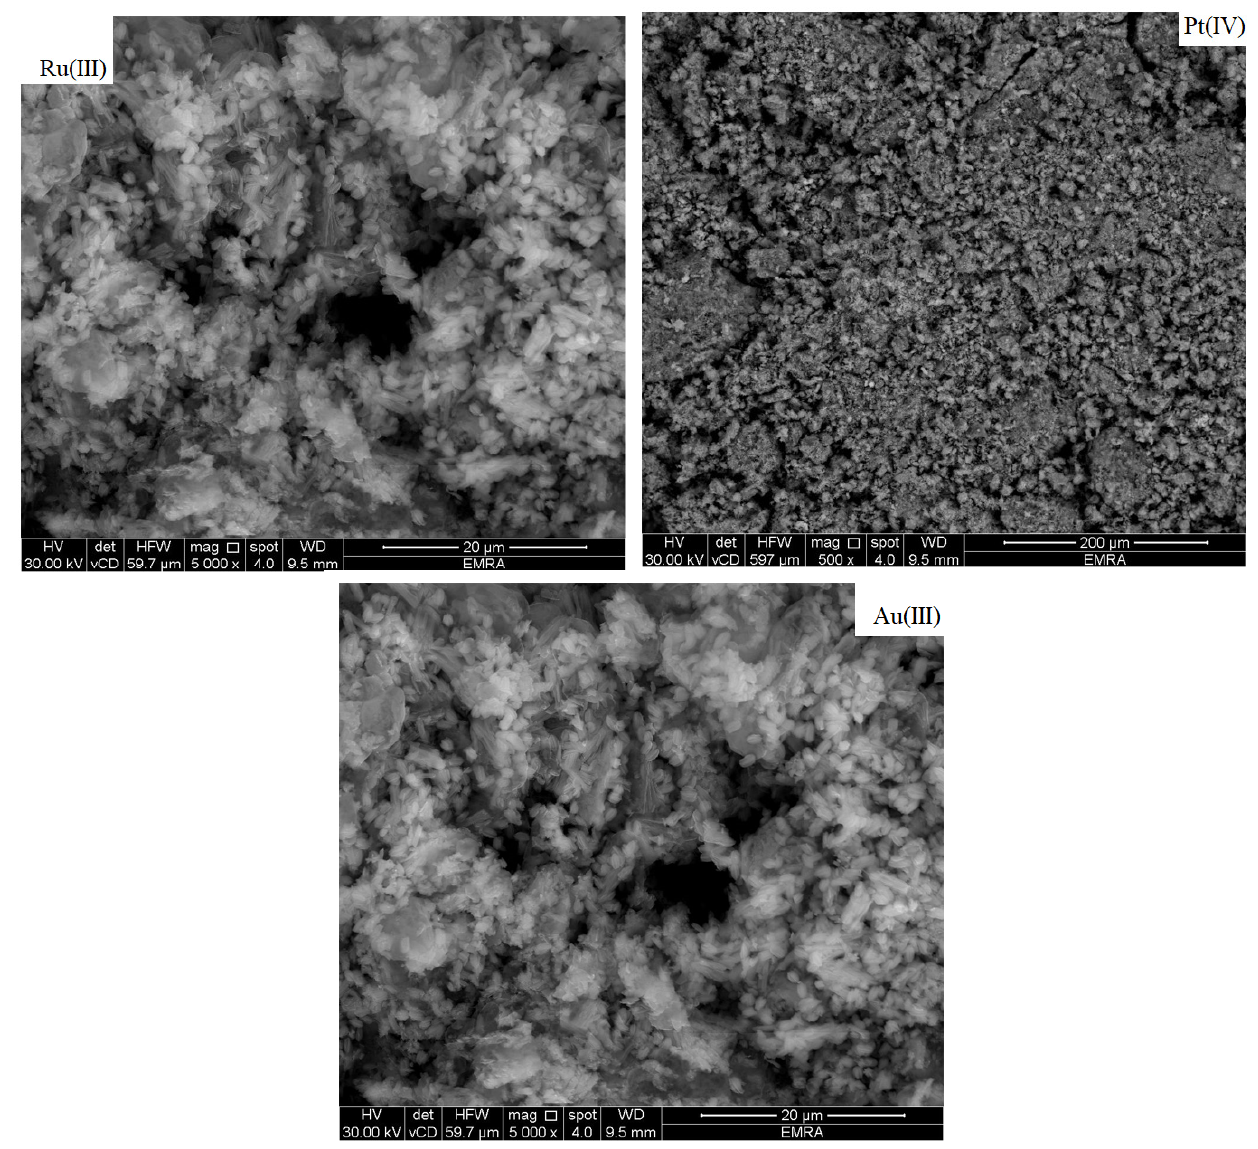
Figure 4. SEM images of for Au (III) Pt(IV), and Ru(III), complexes.